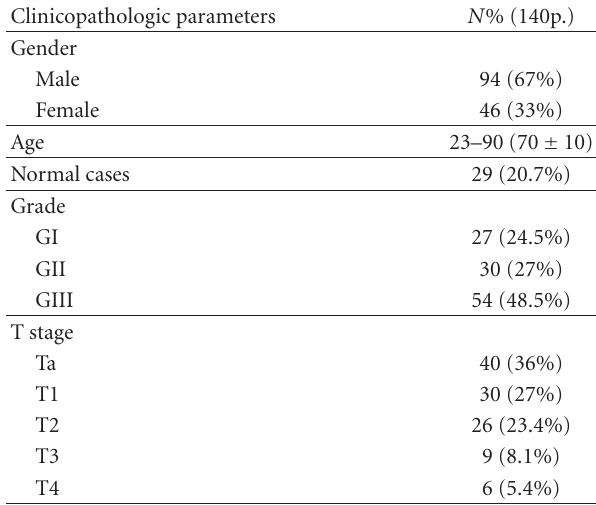
Table 1: Clinical profile of the patients. (Figures in parentheses indicate percentages within histological